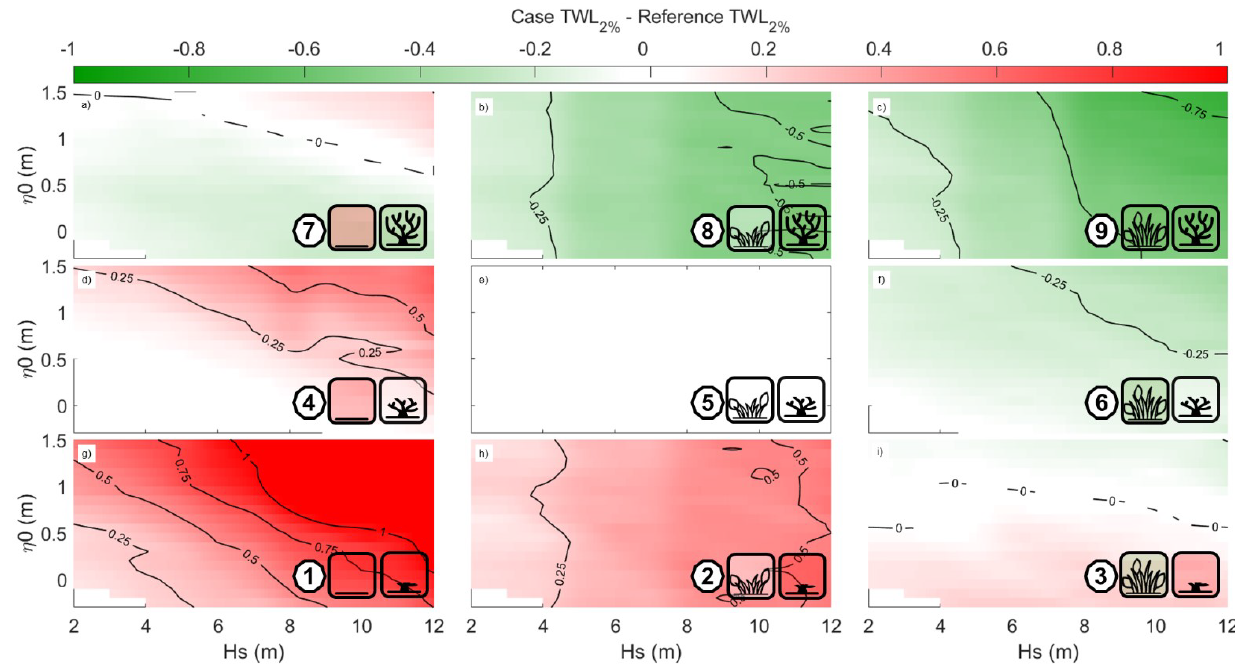
Figure 8. Difference in TWL 2% relative to the reference case as a function of η 0 and H s , the differential color is then expressed in meters. Pictograms represent the status of the ecosystem. On the figures ( a – i ), coral reef status changes from bottom to top, and the vegetation status from left to